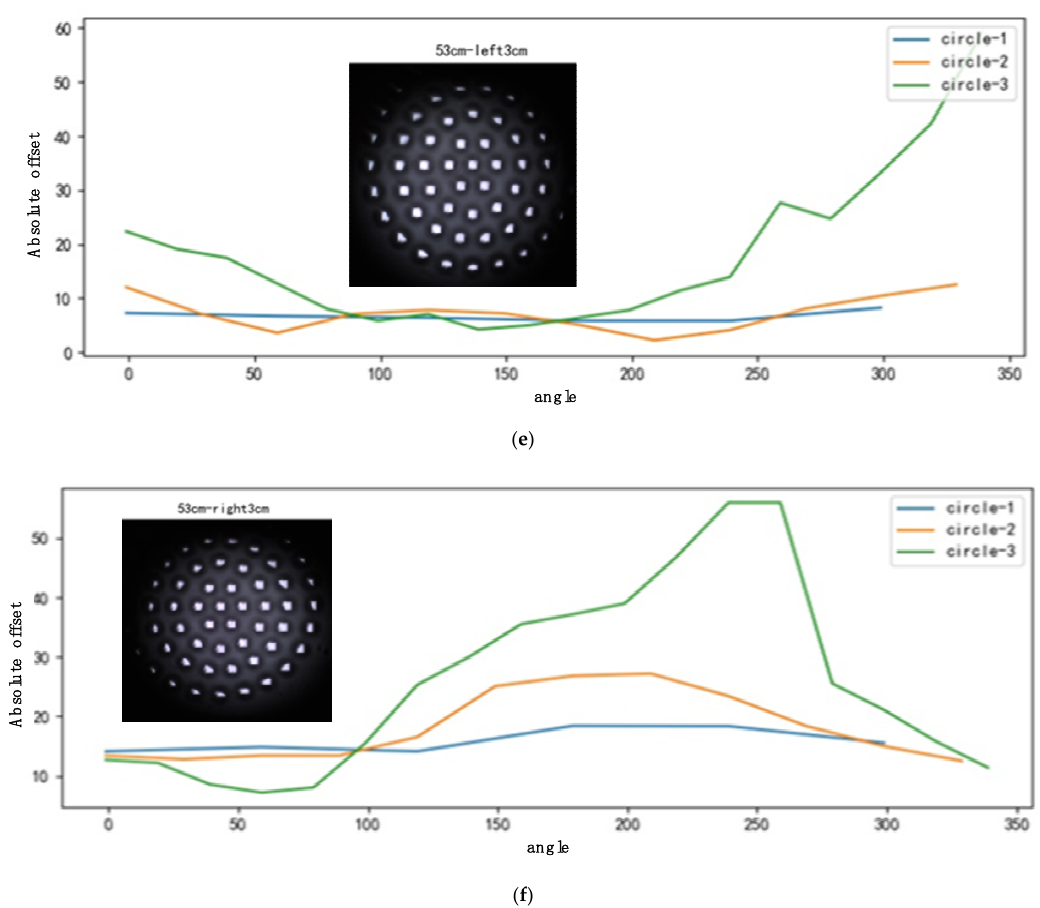
Figure 11. ( a ) The captured image of Lena; ( b ) the stitched image of all sub-images; ( c ) the rapid recognition result of the image of the planar MLA; ( d ) the rapid recognition result of the image of the curved compound eye; ( e ) the analysis result of the white block when it is moved 3 cm to the left; ( f ) the analysis result of the white block when it is moved 3 cm to the right.